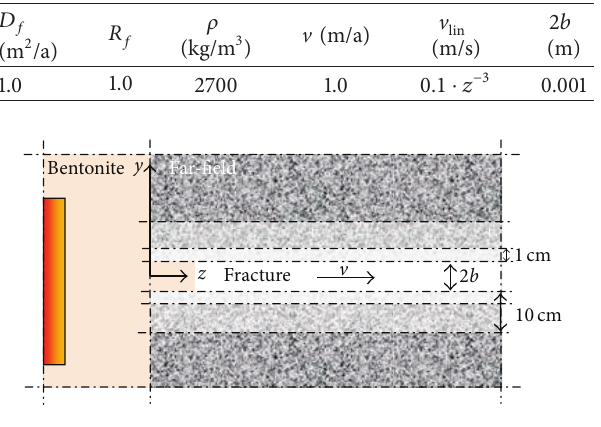
Figure 4: Modify geometry of proposed model.